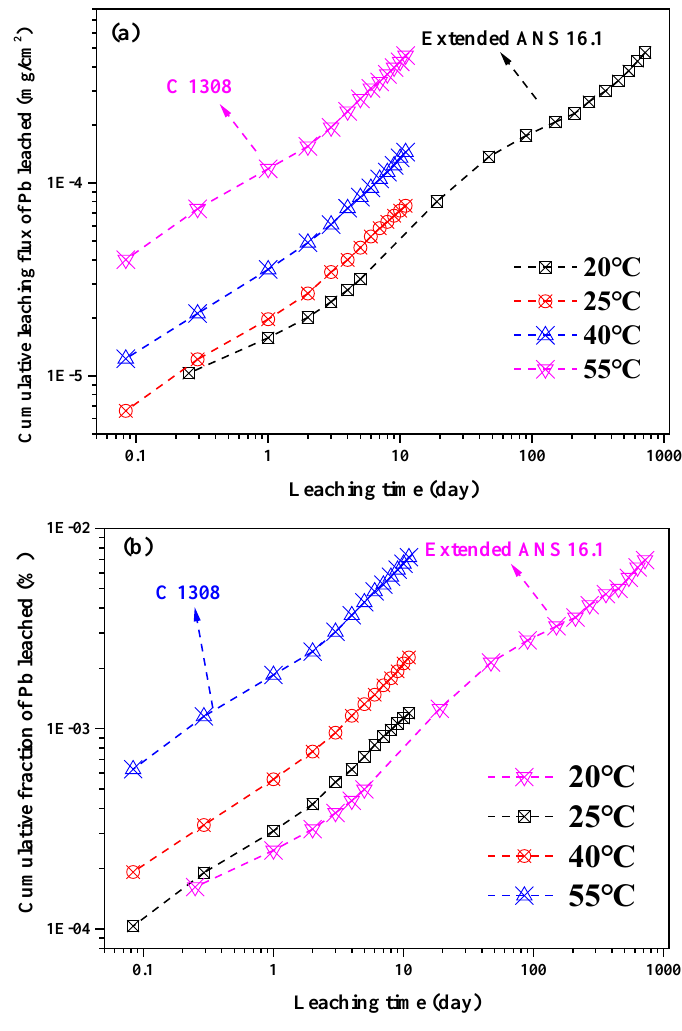
Figure 2. Short-term accelerated leaching versus long-term leaching: ( a ) cumulative leaching flux; ( b ) cumulative leaching fraction.